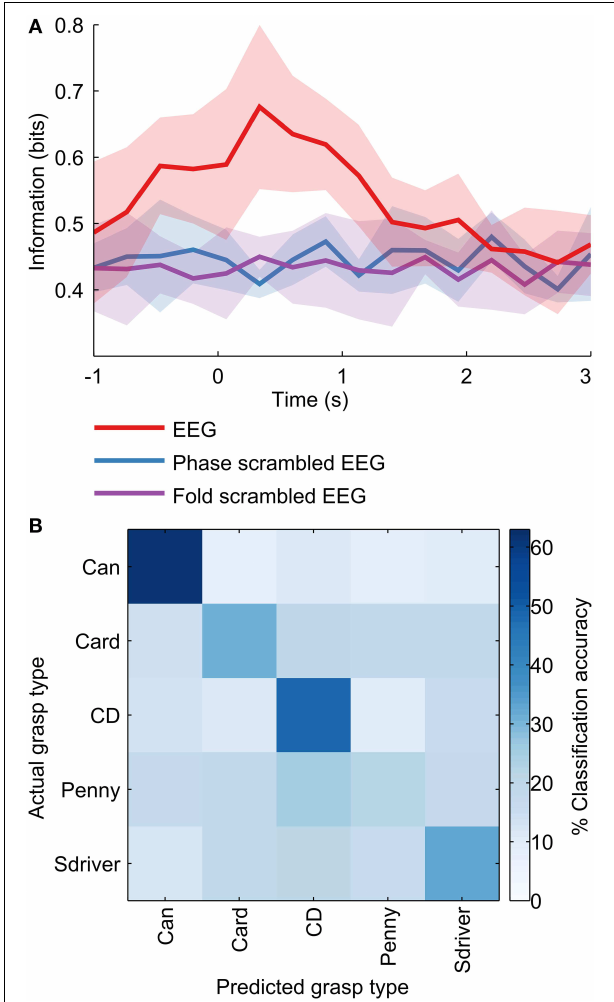
FIGURE 6 | Information content in EEG. A discrete classifier predicted the object being grasped from 100ms windows of preprocessed EEG at various points in time during the grasp. (A) The information content was calculated as the reduction in the entropy of the distribution over grasp types due to the classifier. Information in EEG peaked at around 250ms after movement onset. (B) The classifier confusion matrix at 250ms after movement onset is diagonal, indicating high classification accuracies. Precision grasps were classified with a lower accuracy (27%; card, penny) than whole-hand grasps (48%; can, CD, screwdriver). The overall decoding accuracy was 40% across the 5 objects, with chance level at 20%.